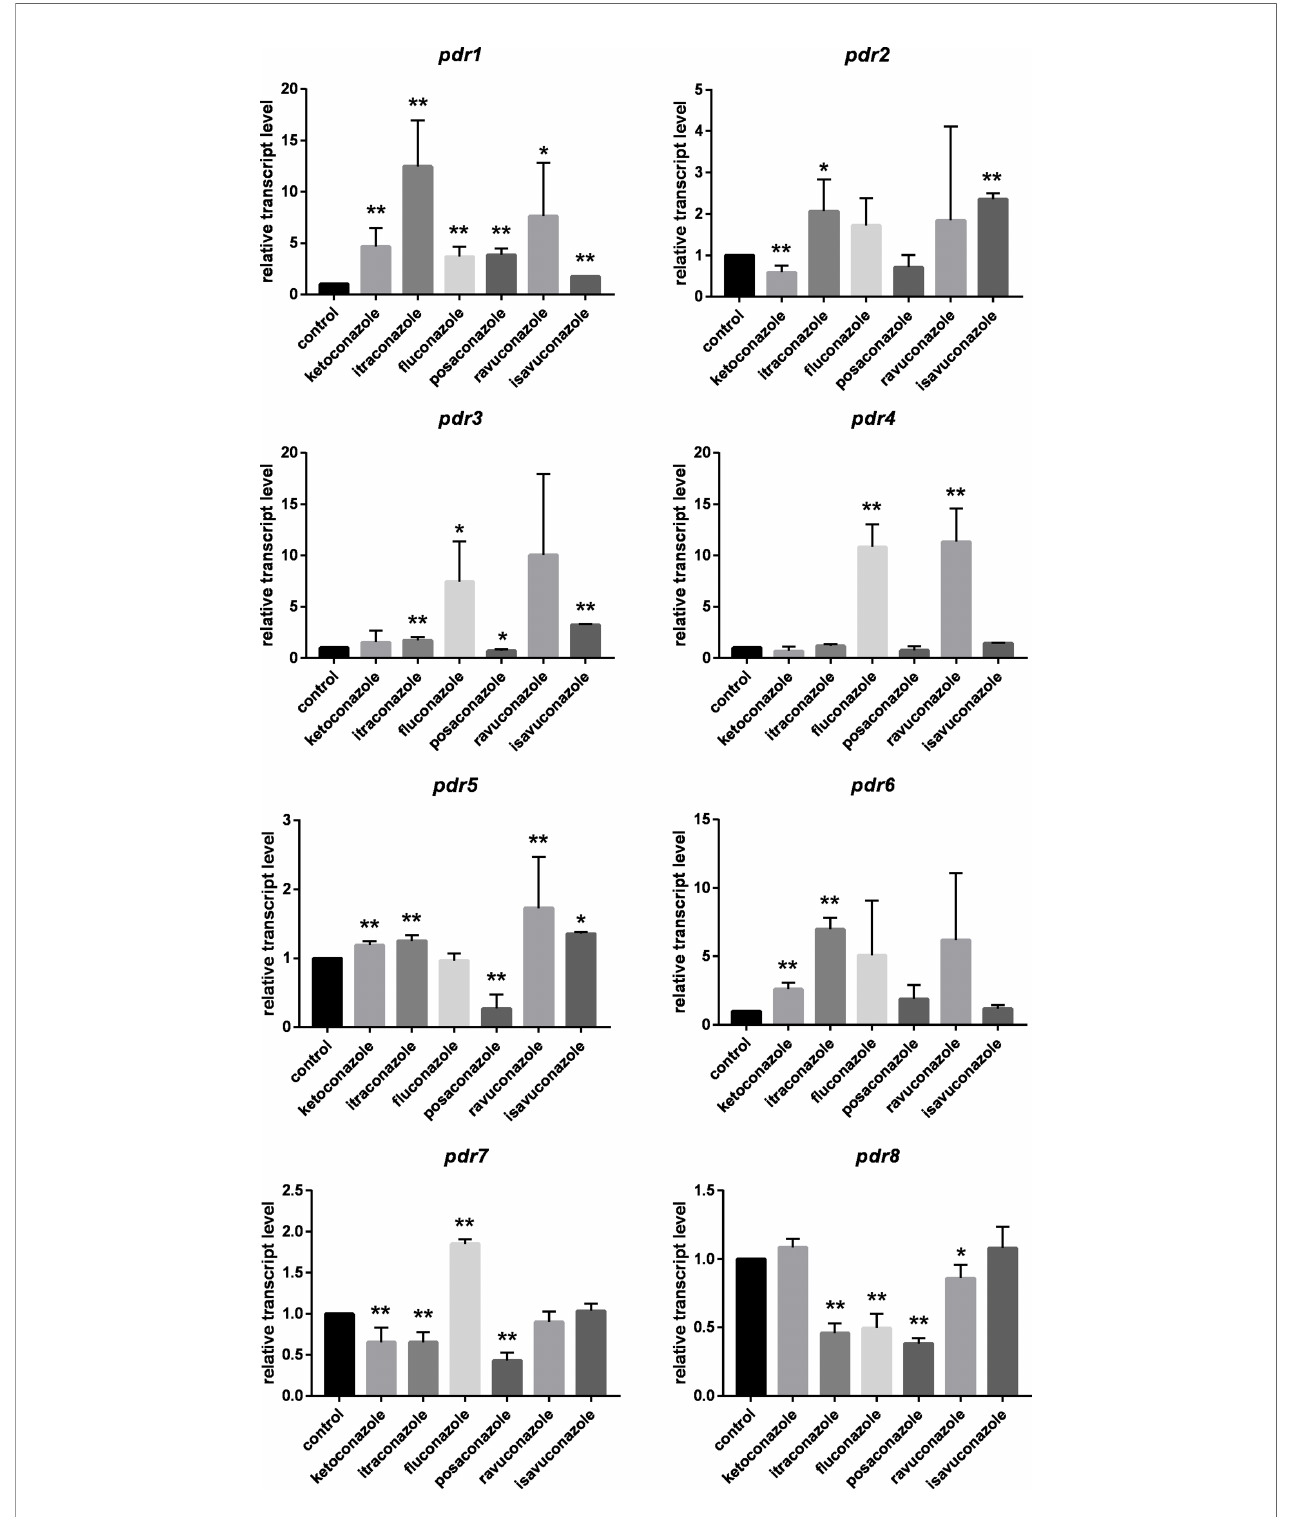
FIGURE 2 | Relative transcript levels of the pdr genes of M. circinelloides after azole treatment. MS12 was grown in RPMI-1640 liquid media at 25°C; transcript level of each gene measured in the untreated control was taken as 1. The presented values are averages of three independent experiments; error bars indicate standard deviation. Relative transcript values followed by * and ** signi fi cantly differed from the untreated control according to the paired t-test (* p < 0.05 and ** p < 0.01).